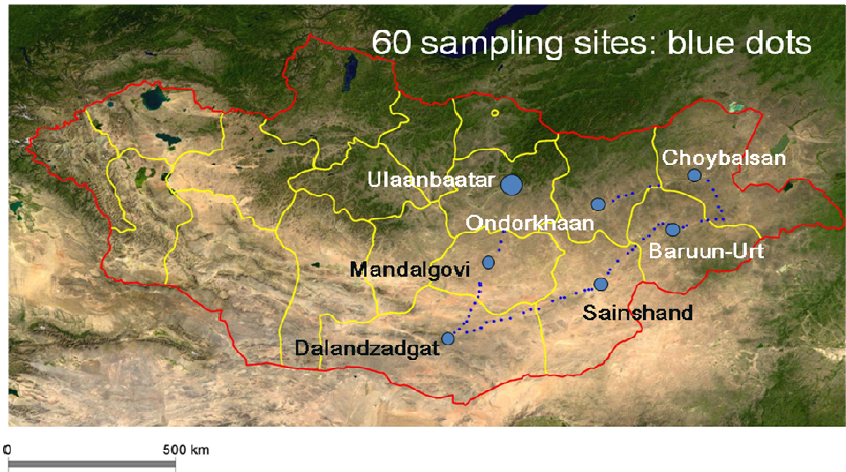
Fig. 1. Sampling sites of a survey of anthropogenic radionuclides in surface soil in Mongolia in the fall of 2007. Red and yellow lines indicate Mongolian and aimag (prefecture) borders, respectively. Small blue dots are the sampling sites, and the large ones are cities and towns, which were avoided for sampling. The background land color image is from TNT Global Data Sets (MicroImages, Inc., Nebraska, USA).